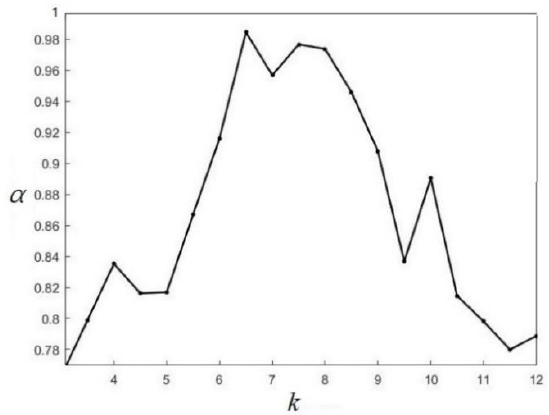
Fig. 6. The relationship between reduction coefficient with size ratio 7 . 77 k 